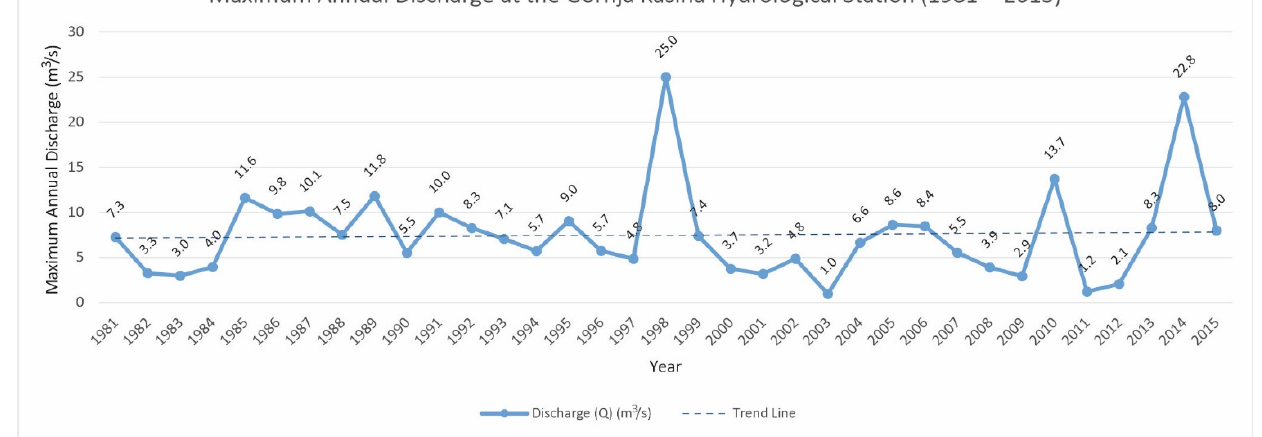
Figure 3. Maximal annual discharges at the “Gornja Kašina” stream gauge between 1981 and 2015.